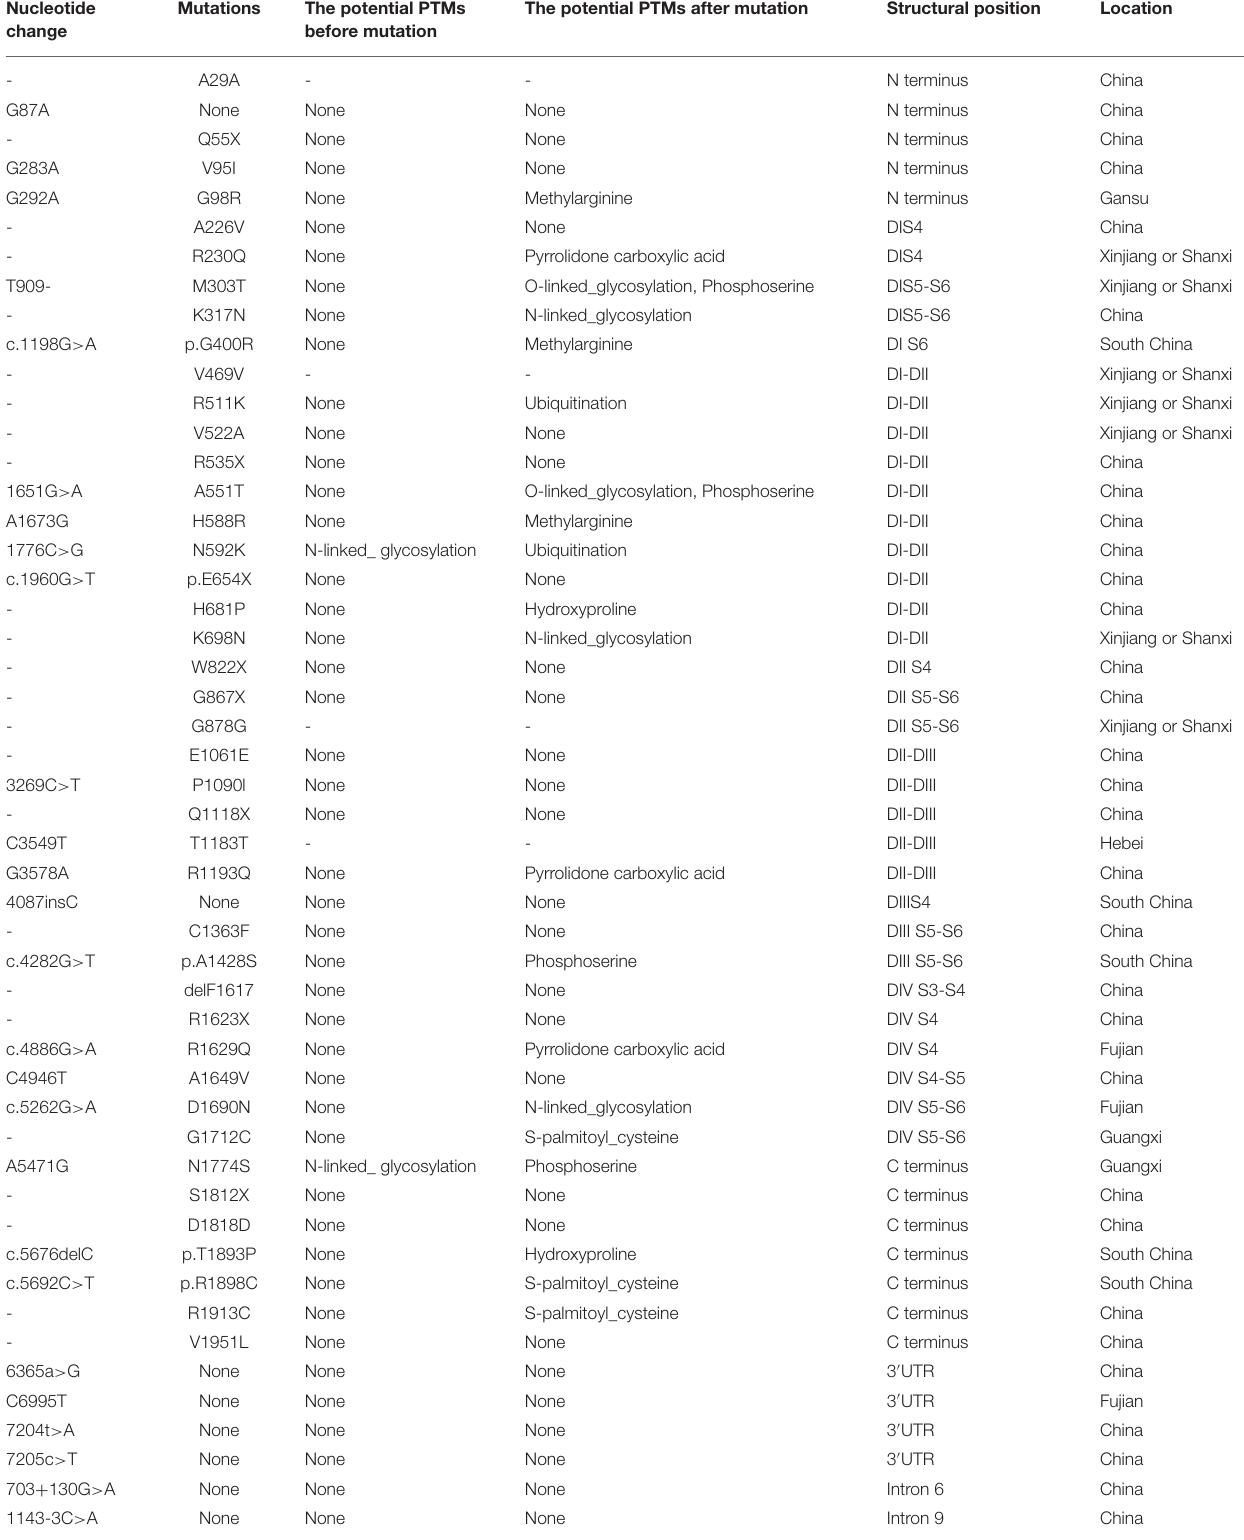
TABLE 2 | The PTMs of SCN5A variants in Chinese BrS patients. Nucleotide